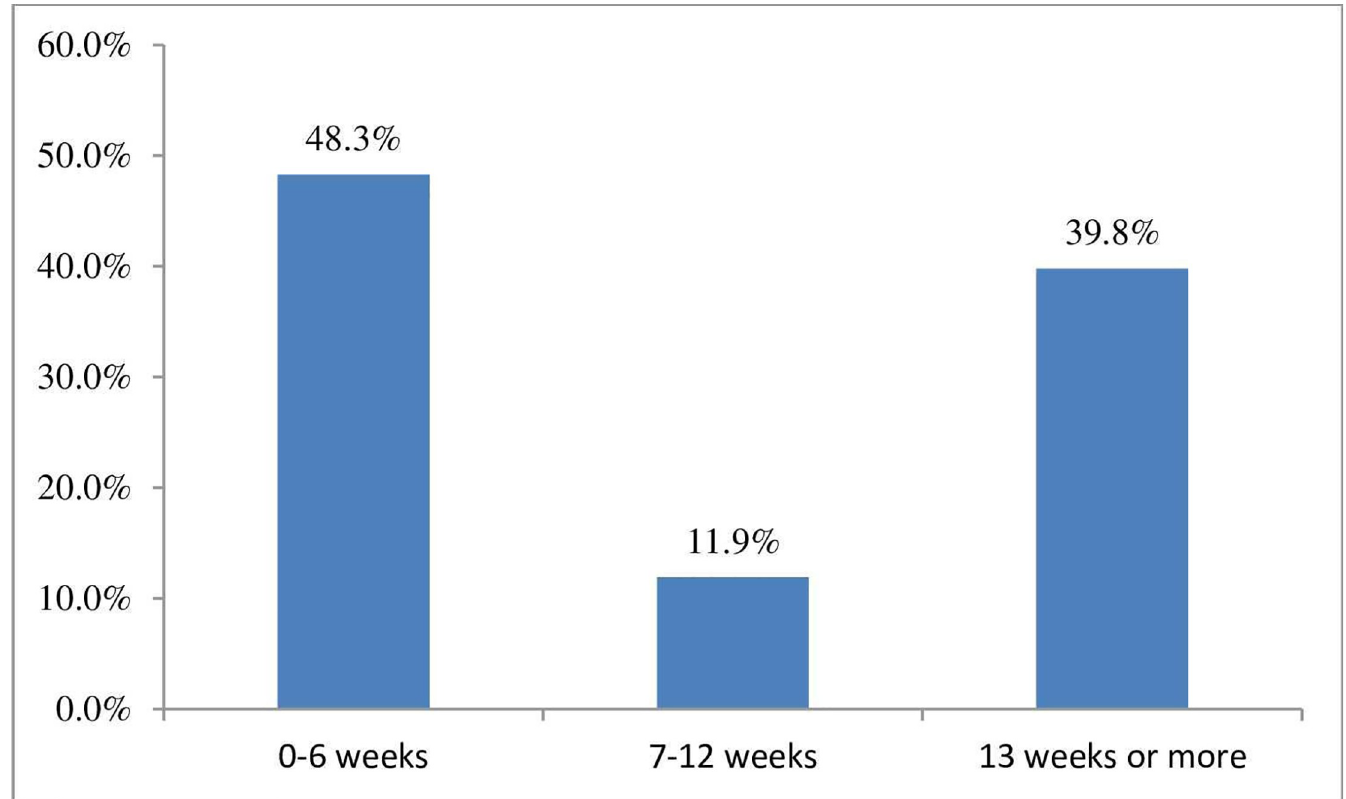
Fig 1. Duration of current symptoms for this symptom episode for patients presenting at their first appointment.